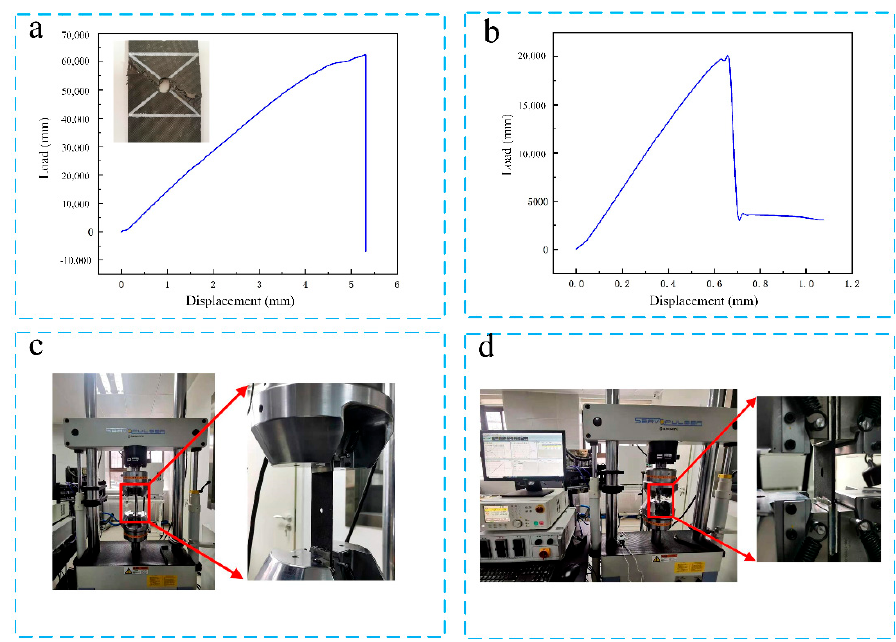
Figure 6. ( a ) Tensile test; ( b ) compressive test; ( c ) tensile/tensile fatigue experiment setup; and ( d ) compressive/compressive fatigue experiment setup.